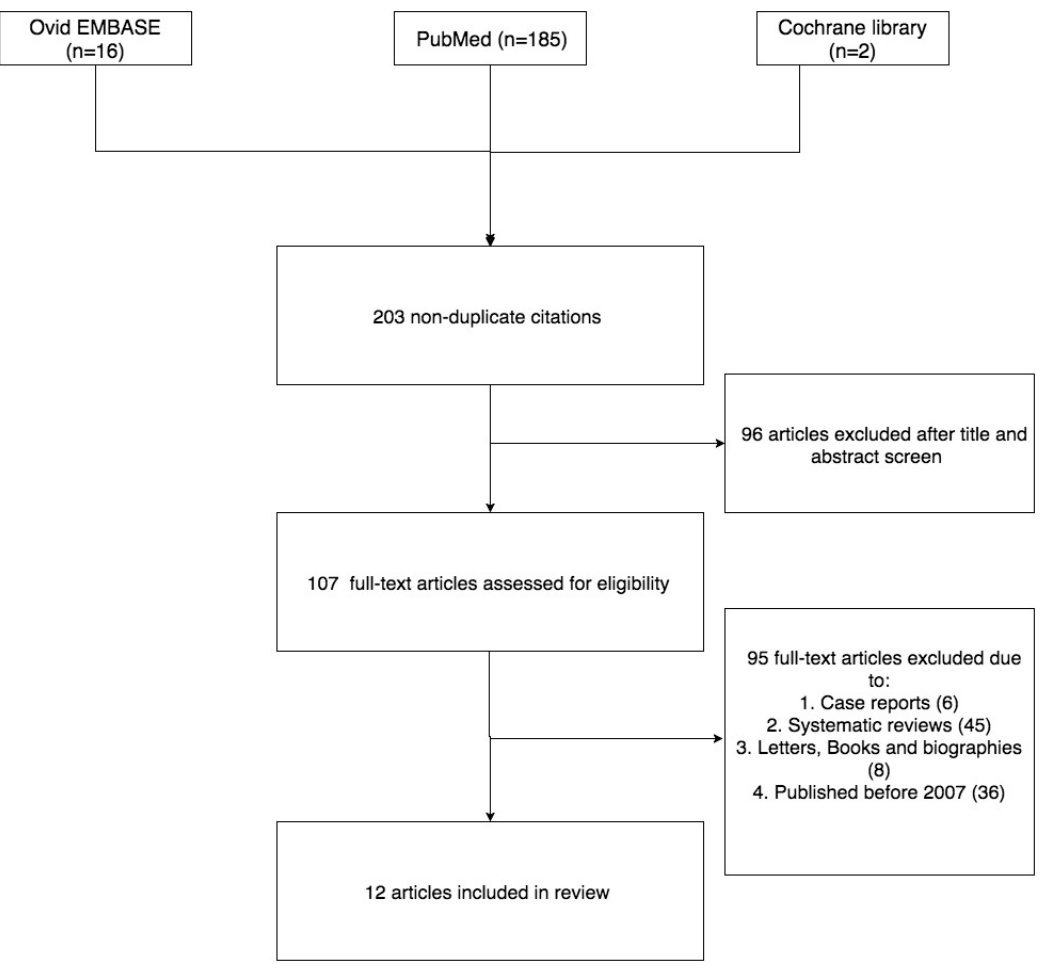
Figure 1. Figure explaining the selection of studies included in the review.